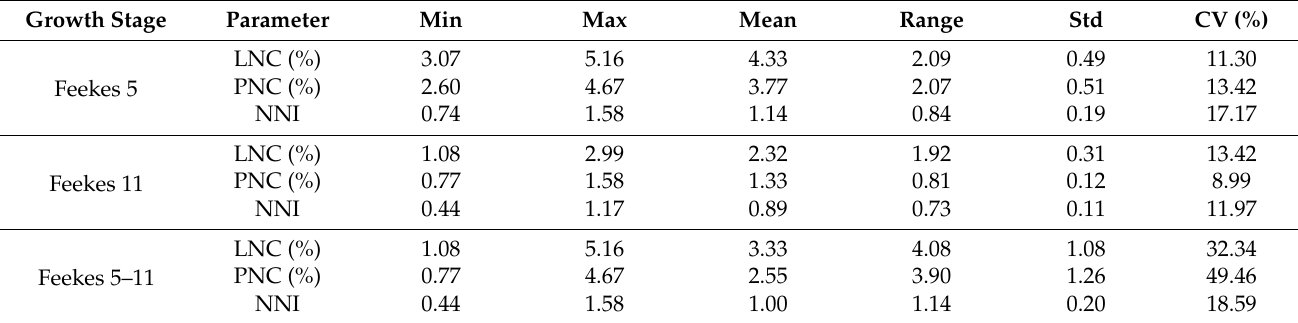
Table 6. Descriptive statistics of winter wheat LNC, PNC, and NNI across different growth stages.